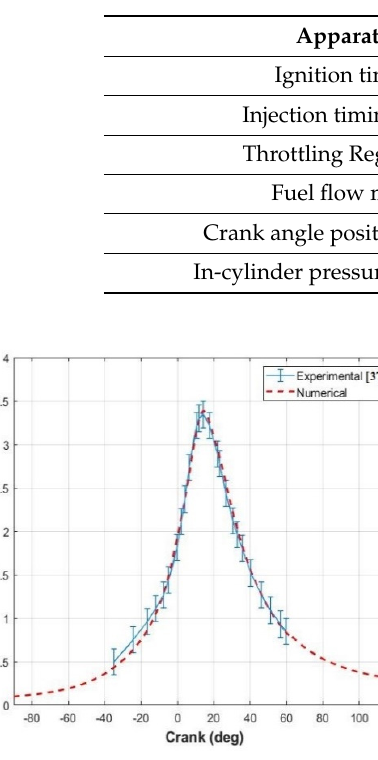
Table 5. Instrumentation apparatus for measurement. Reproduced with permission from Aghahasani, M., etc., Energy Convers Manag.; published by Elsevier, 2022 [38].